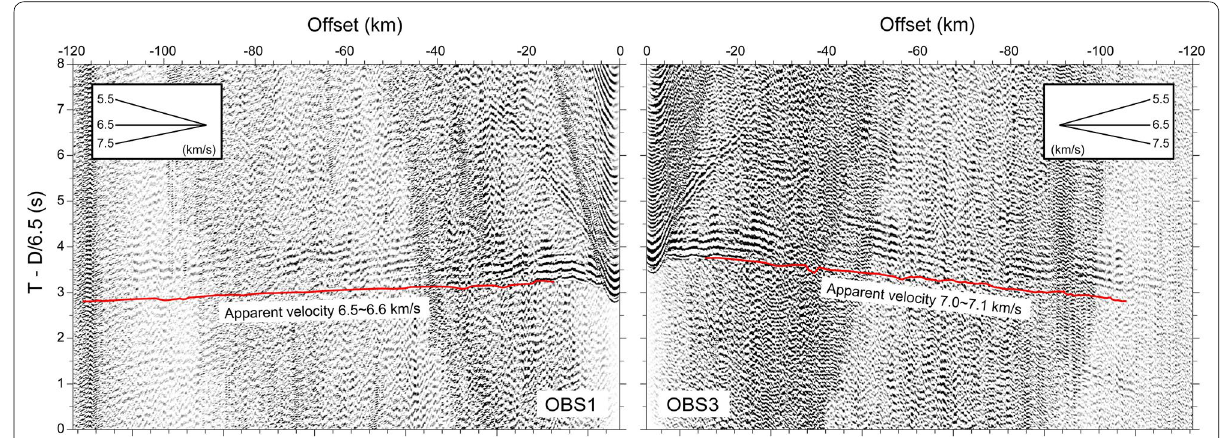
Fig. 8 Record sections from OBS1 and OBS3. Reduction velocity is 6.5 km/s. The red lines indicate the calculated travel times of P3